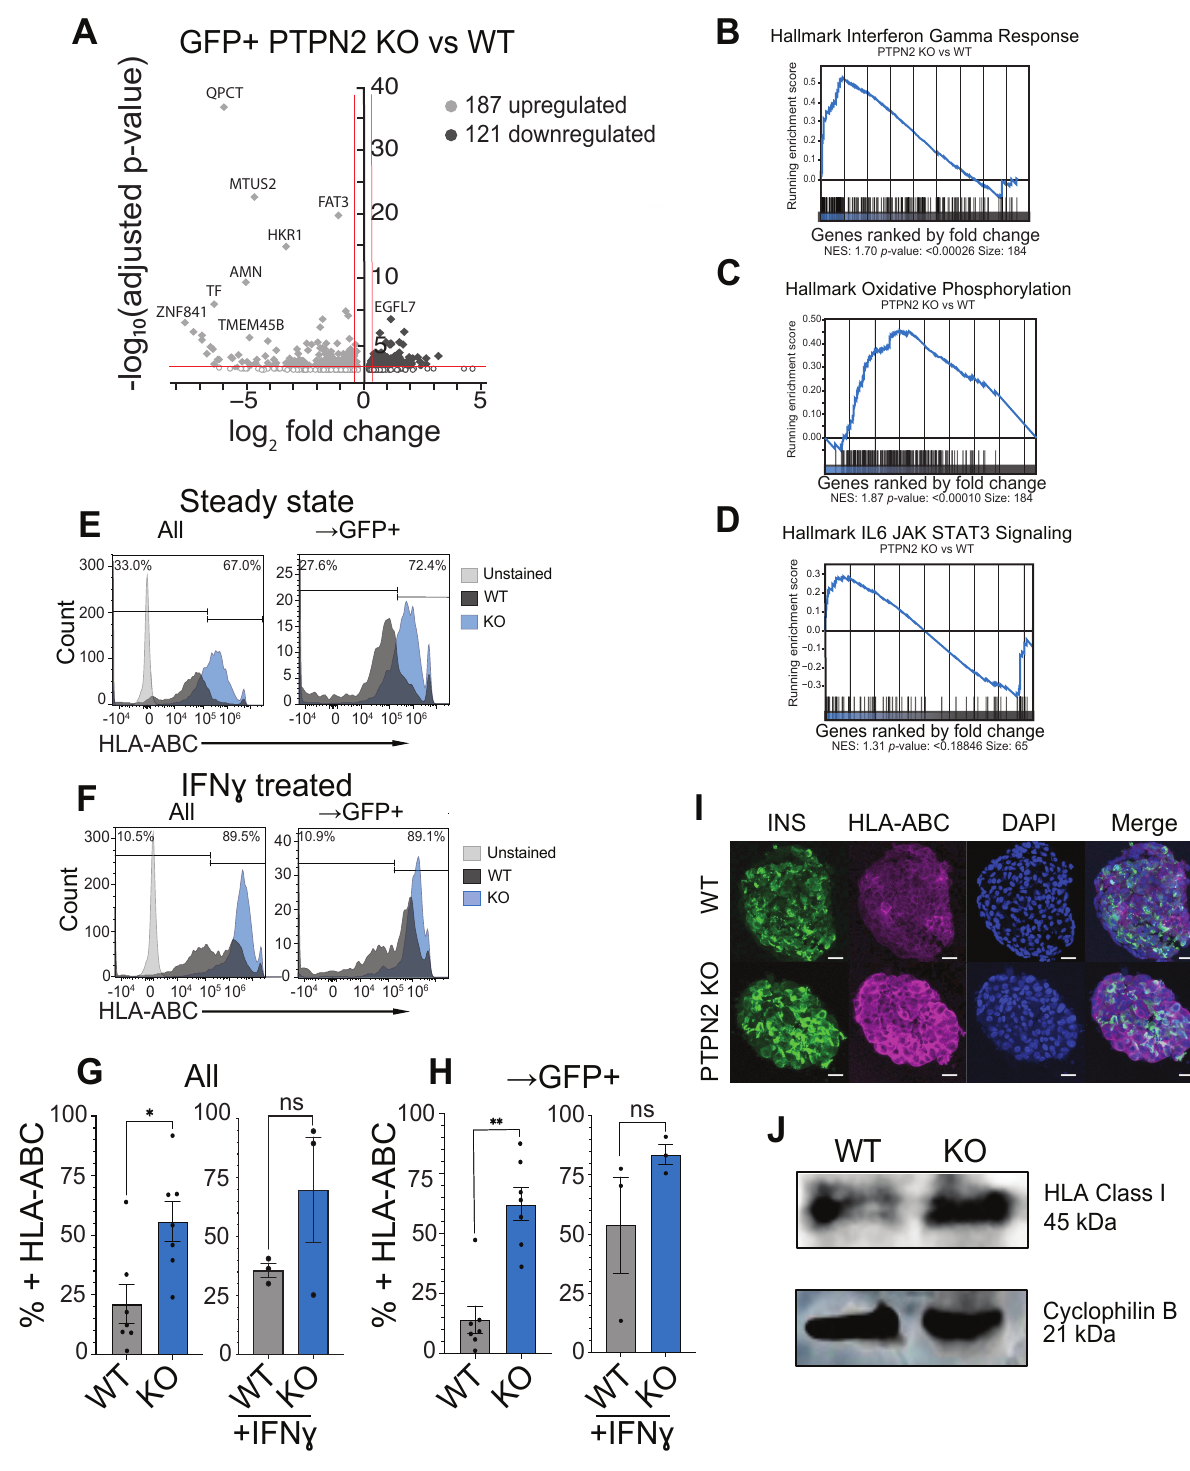
Figure 3. PTPN2 KO sBC displayed increased HLA class I expression. ( A ) Volcano plot of bulk RNAseq differential gene expression of GFP+ WT and PTPN2 KO sBCs. An adjusted p -value of